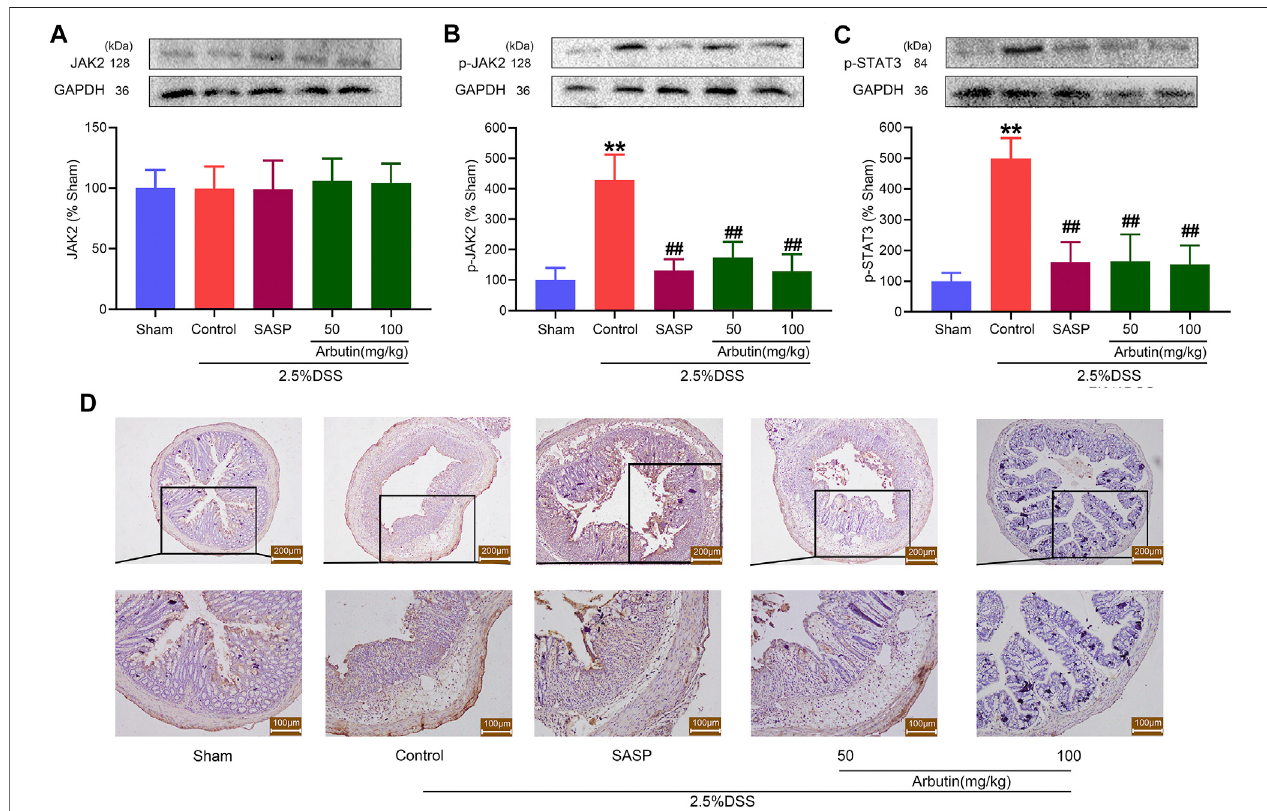
FIGURE5 | Arbutin inhibited JAK2signaling pathway in colon. The proteins associated withthe JAK2 pathway were detected in mice. Western blot analysisof (A) JAK2, (B) p-JAK2,and (C) p-STAT3 (D) ExpressionofSOCS3determinedbyImmunohistochemicalstaininginthecolonicepithelium.Scalebars,200(upperpanel)and 100 μ m(lowerpanel).Datawereexpressedasmean ± SD.** p < 0.01comparedwithshamoperationgroup;## p < 0.01comparedwithDSSinducedcolitisgroup; n (cid:1) 3 samples for Western blot experiments; n (cid:1) 6 samples for other